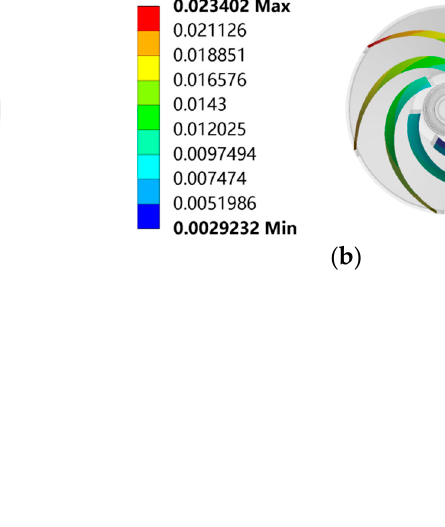
Figure 11. Deformation cloud diagram of the impeller working face, mm. ( a ) 0.4 Q d . ( b ) 1.0 Q d . ( c ) 1.3 Q d .